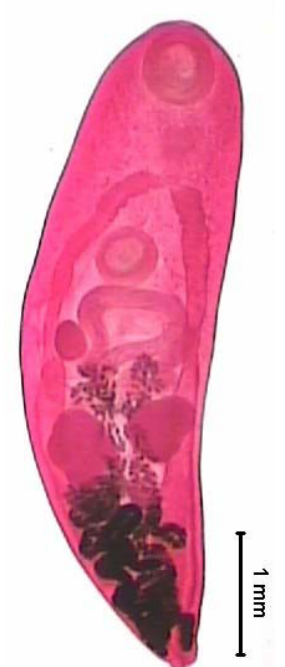
Figure 1. Specimen of Opisthogonimus fonsecai collected from the mouth of a Bothrops moojeni